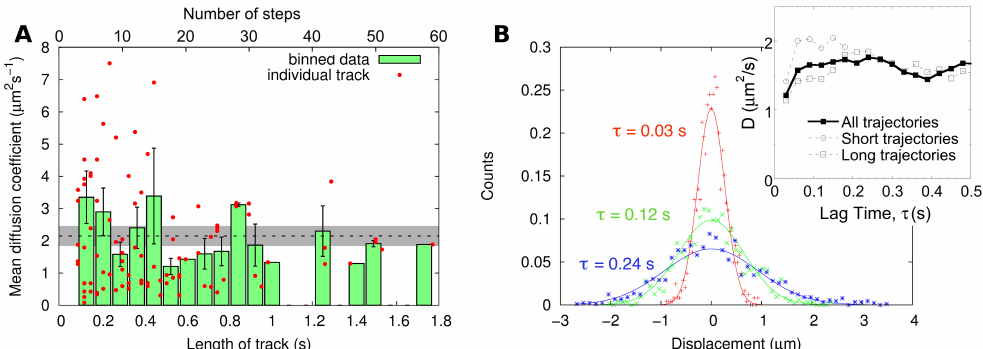
Figure 4. ( A ) A comparison between the length of the acquired track and the determined diffusion coefficient using mean-squared displacement (MSD) analysis of single tracks. The spread of the diffusion coefficient values decreases with track length. The dotted line indicates the value of the diffusion coefficient determined using MSD analysis of the combined track ( D = 2.2 µ m 2 · s − 1 ). ( B ) Distribution of displacements for all trajectories at different lag times (coloured symbols). Each of these distributions is fitted with a normal distribution according to Equation (5) (solid lines). The inset shows the dependence of the value of the diffusion coefficient obtained in this way as a function of lag time, when considering all trajectories (filled symbols) or only short (less than 0 . 5 s) or long (more than 1 s)